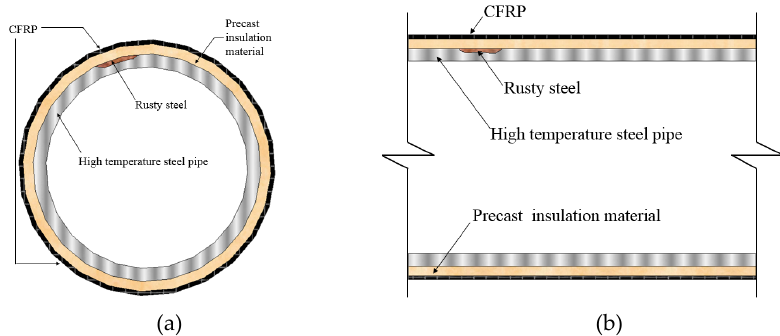
Figure 1. The proposed strengthening method for high-temperature steel pipe. ( a ) Lateral cross-section; ( b ) Longitudinal cross-section.